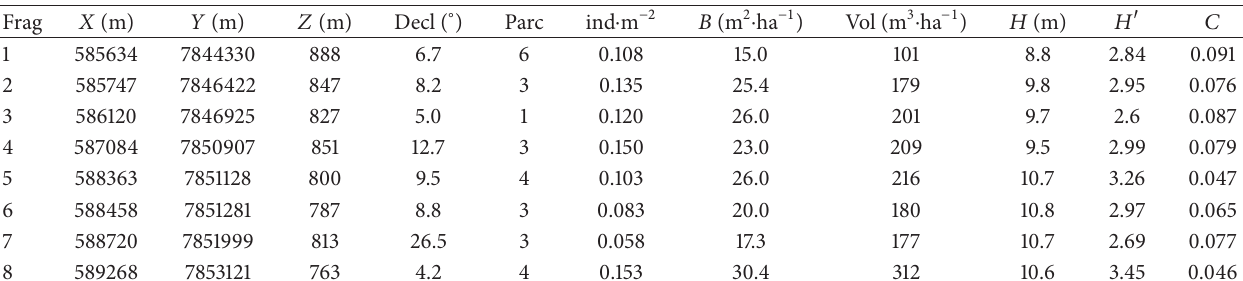
Table 1: Coordinates ( 𝑋 , 𝑌 ) UTM/ 23 Zone WGS84 of the 1st permanent plot in the fragments, geometric altitude ( 𝑍 ), declination in degrees (Decl), number of permanent plots (Parc), individual density (ind ⋅ m − 2 ), basal area ( 𝐵 ), volume (Vol), average tree height ( 𝐻 ), Shannon index ( 𝐻 󸀠 ), and Simpson dominance index ( 𝐶 ).